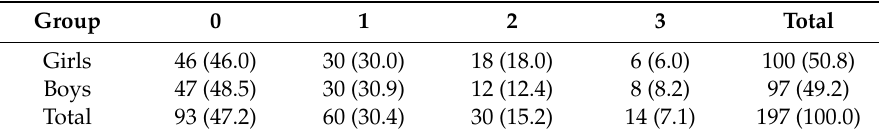
Table 3. Participants with di ff erent number of CVD by sex (n = 197).